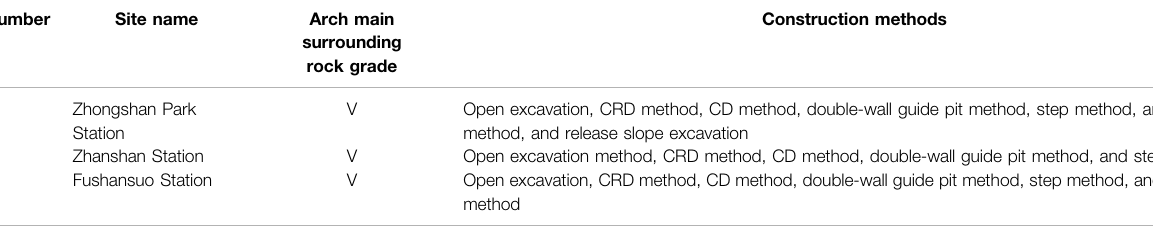
TABLE 3 | Main construction methods of underground excavation station of subway line